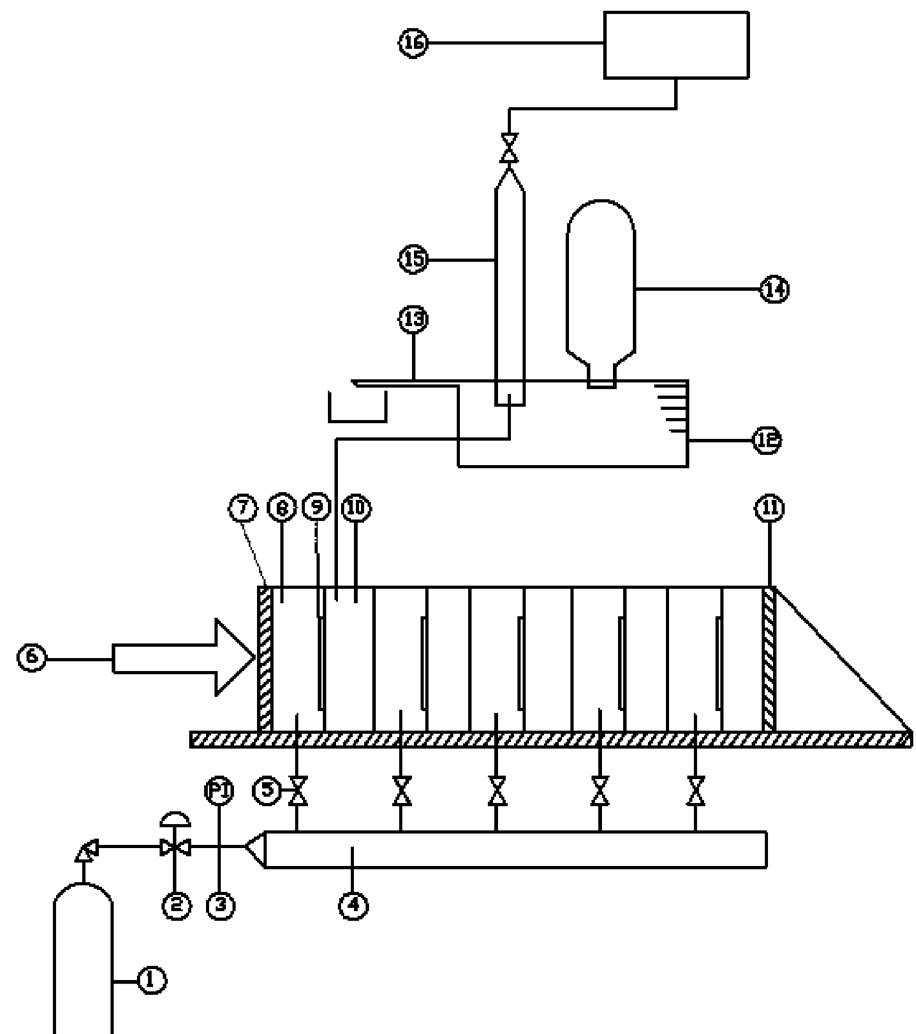
Fig. 5 Schematic drawing of the permeameter under development with acces- sories. 1. High pressure bottle containing test gas, 2. Pressure regulating valve, 3. Line pressure gauge, 4. Test gas distributor, 5. Permeation chamber shut-off valve (10x), 6. Hydraulic system for closing the permeation chambers, 7. Moving steel plate, 8. Test gas inlet in the permeation chamber—upstream (10x), 9. Sample, 10. Test gas inlet in the permeation chamber— downstream (10x), 11. Fixing and closing structure of the permeation chambers, 12. Liquid deposit for measuring system, 13. Outlet of excess liquid from the reservoir,